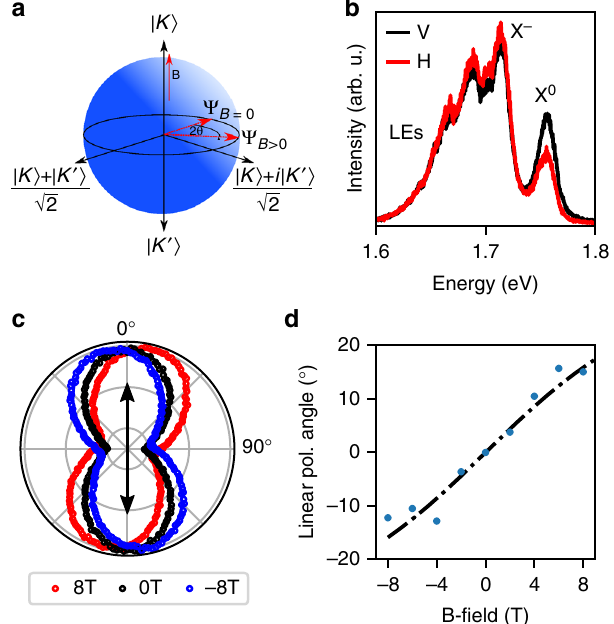
Fig. 1 Valley coherence in WSe 2 excitons. a Bloch sphere representation of the valley pseudospin vector. Valley polarized states ( K j i and K ′ j i ) lie on the poles of the sphere while valley coherence is represented by a Bloch vector oriented on the equator. The application of a perpendicular magnetic fi eld leads to precession of the pseudospin vector around the equator due to the valley Zeeman effect, evolving from a position Ψ B = 0 to Ψ B >0 . b Vertically (V) and horizontally (H) polarized spectra under vertically linearly polarized excitation. Retention of injected valley coherence is present for the neutral exciton, X 0 , with a polarization degree of 15%. c Rotation of the linear polarization plane around the equator under perpendicular magnetic fi elds of 8, 0, and − 8 T, respectively. The black arrow indicates the injected linear polarization. d The linear polarization angle ( θ ) as a function of applied fi eld. Blue circles are data points and dot- dashed black line is a fi t corresponding to θ = arctan( Ω B T 2 )/2 where Ω B is the precession frequency given by Ω B = g μ B B / ħ and T 2 is the coherence time. The fi t corresponds to T 2 = 0.52 ± 0.05